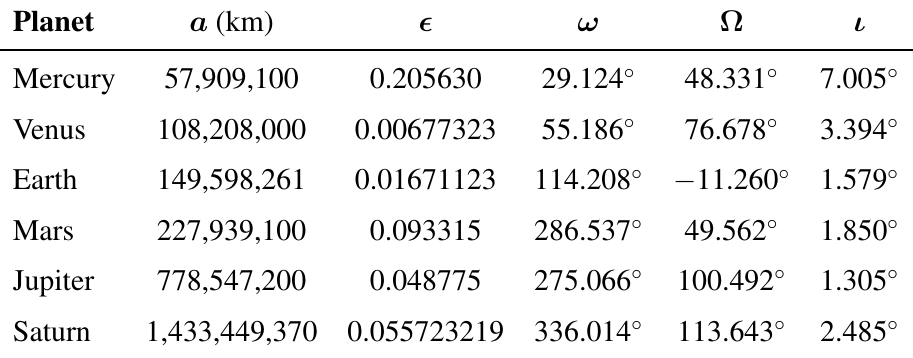
Orbital elements of the planets: a : Semi-major axis; (cid:15) : orbital eccentricity; ω : argument of the perihelion; Ω : longitude of the ascending node; and ι : inclination of the orbital plane with respect to the ecliptic plane. All angles are given in sexagesimal